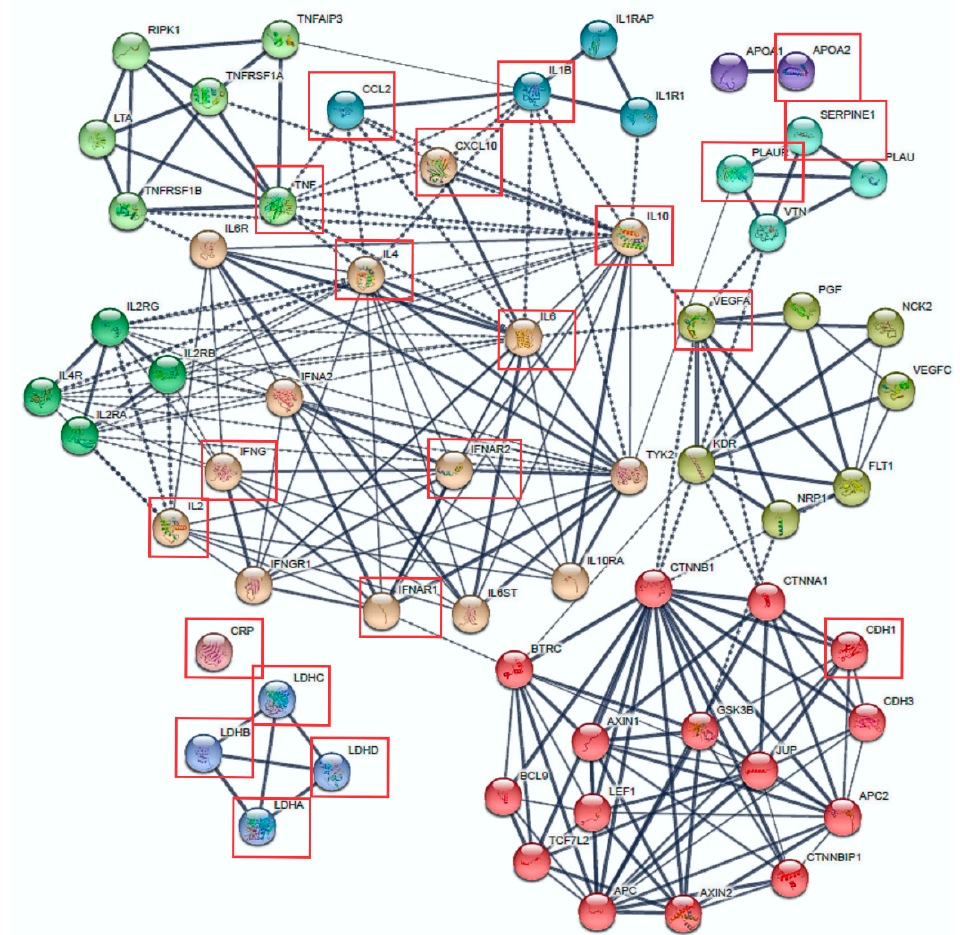
Figure 1. Protein–Protein Interaction network built from 21 candidate genes associated with COVID-19 aggressiveness. The 21 genes were entered in STRING (string-db.org/, accessed on 20 June 2020) and the network was enlarged to determine inter-cluster connections (dashed lines). The thickness of the lines is determined by the strength of the data support. Clusters were generated with the MCL algorithm with an inflation parameter of 3. Red squares mark the 21 backbone genes associated with COVID-19 severity.